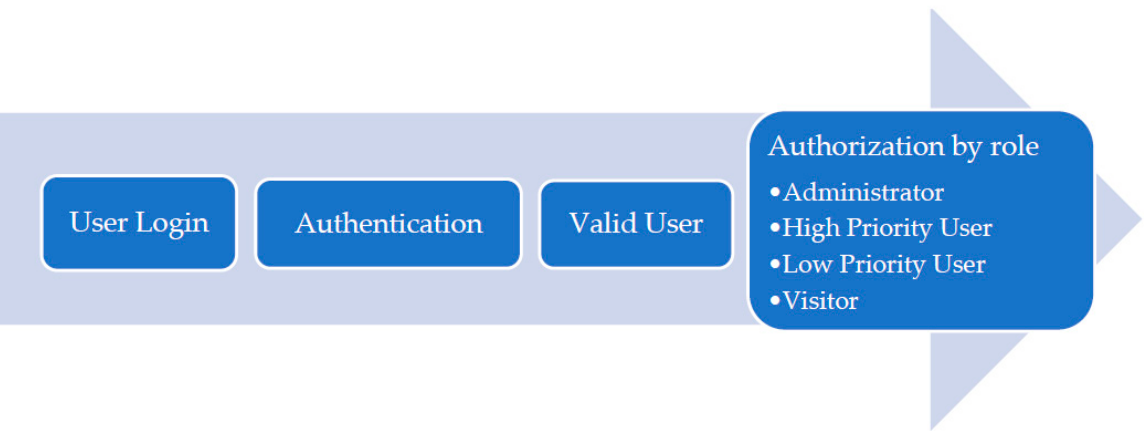
Figure 10. Assignation of users’ roles with priorities to perform actions, and the system to receive and execute commands.